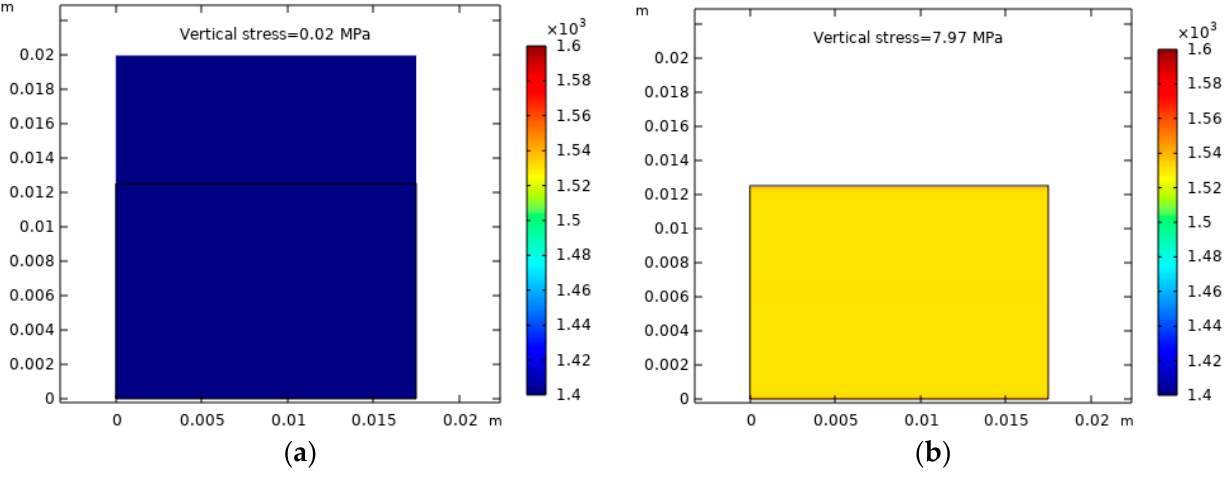
Figure 10. Dry density distribution at different times (( a ) t = 0, ( b ) t = 100 min, ( c ) t = 200 min, ( d ) t = 450 min) (under 21 kPa vertical stress (free swelling), Path ABCD, hydration stage AB).